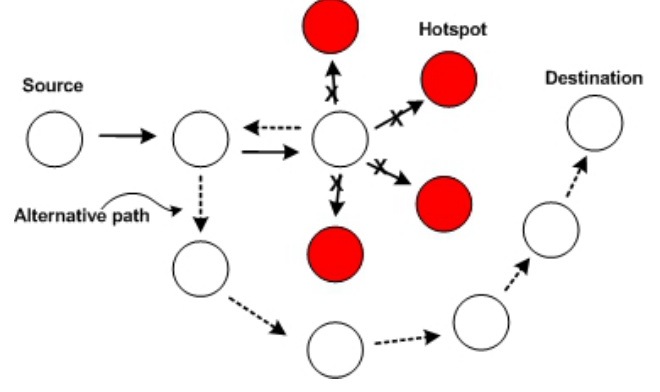
Figure 3. An example of Thermal-Aware Routing Algorithm